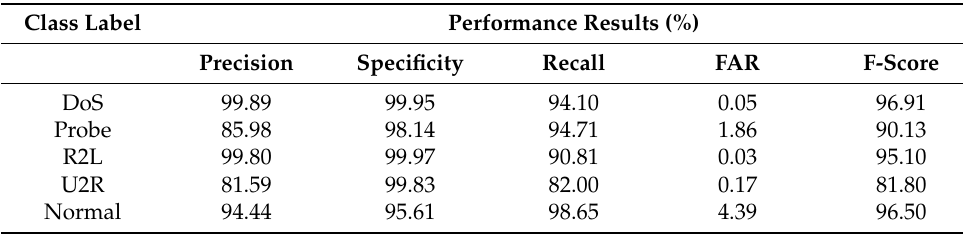
Table 17. BidLSTM performance results on NSL-KDDTest + using 17 features.